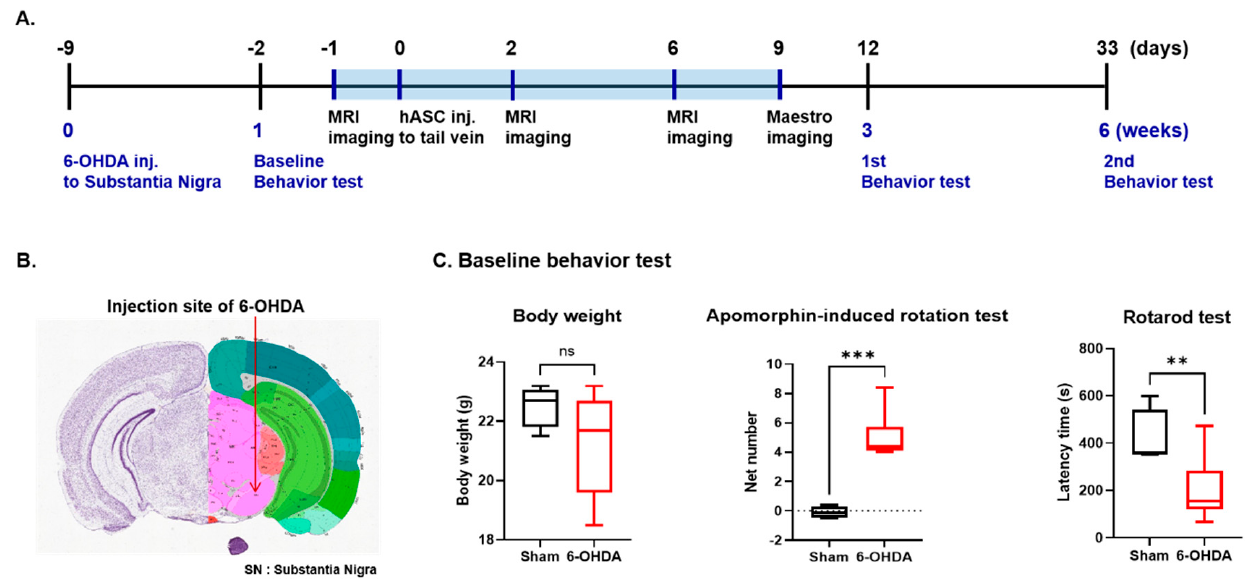
Figure 1. Experimental procedures. ( A ) Experimental scheme for in vivo imaging and behavioral tests. ( B ) The 6-OHDA was stereotaxically injected into the Substance Nigra (SN) (AP, − 3.2 mm; ML, − 1.5 mm; DV, − 4.6 mm). The coronal section from the Allen Brain Atlas shows the SN region (arrow). ( C ) Baseline behavioral tests, including body weight, apomorphine- induced rotation test, and rotarod test, were performed in saline-injected control mouse (Sham) and 6-OHDA-induced PD mouse (6-OHDA) 1 week after 6-OHDA injection (n = 10~12 per group). ** p < 0.01, *** p < 0.001. SN, Substantia nigra; 6-OHDA, 6-hydroxydopamine; PD, Parkinson’s disease.